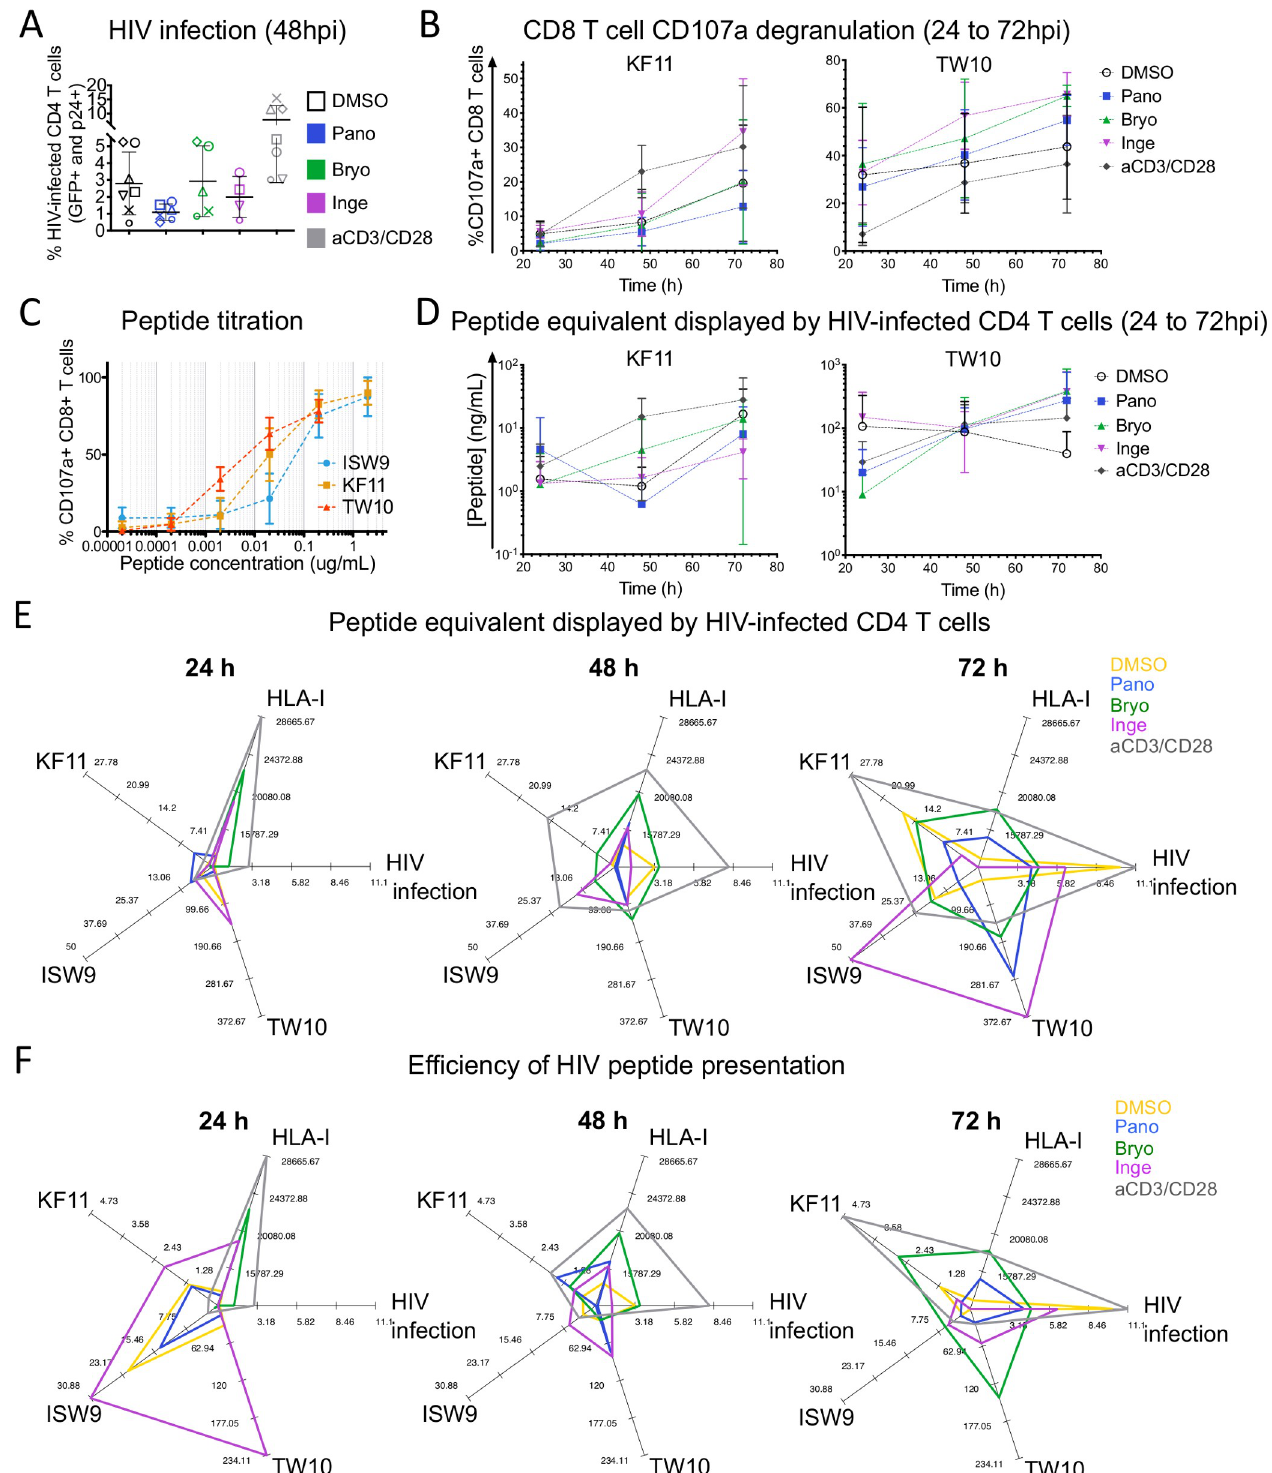
Fig 6. LRAs affect endogenous HIV epitope processing and presentation by HIV-infected CD4 T cells to CD8+ T cells. A. HIV-1 Δ Env-GFP-VSVg infection rate of primary CD4 T cells pretreated with DMSO (black), aCD3/CD28 (grey) or Panobinostat (blue), Bryostatin (green), Ingenol (purple) was assessed by flow cytometry using GFP and HIV-p24 expression at 48 h post-infection (n = 7 donors with distinct symbols). B. Percentage of CD107a+ CD8 T cells specific for HLA-B57 KF11 (left) and HLA-B57 TW10 (right) after incubation with HLA-B57+ HIV-infected CD4 T cells treated with DMSO, LRA or